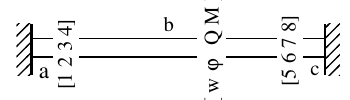
Fig. 5. Displacement and force indices of fixed-fixed beam element.